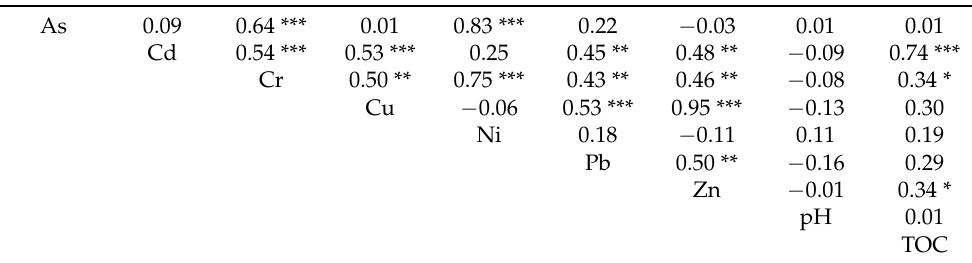
Figure 2. PCA biplot of pH, TOC and PTEs. Table 2. Correlation matrix of the soil PTE contents; * significant at p = 0.05; ** significant at p = 0.01; *** significant at p = 0.001.